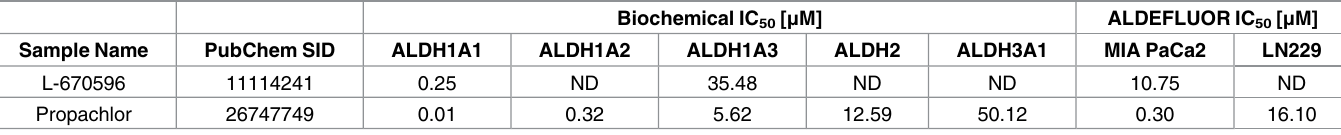
Table 2. IC 50 values of ALDH1A1-selective compounds identified from dual cell-based